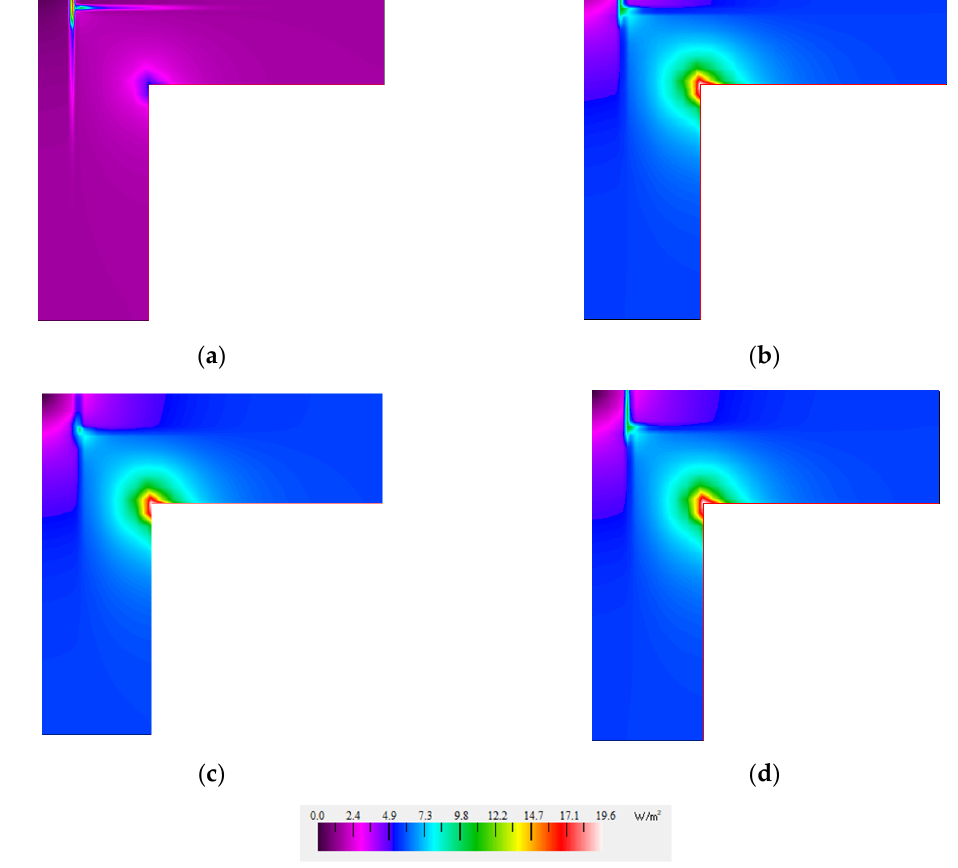
Figure 4. The heat flow rate through the corners of the wall insulated with PIR, faced with different facings: ( a ) aluminum foil, ( b ) multilayer aluminized facing, ( c ) composite paper facing, ( d ) plastic facing.